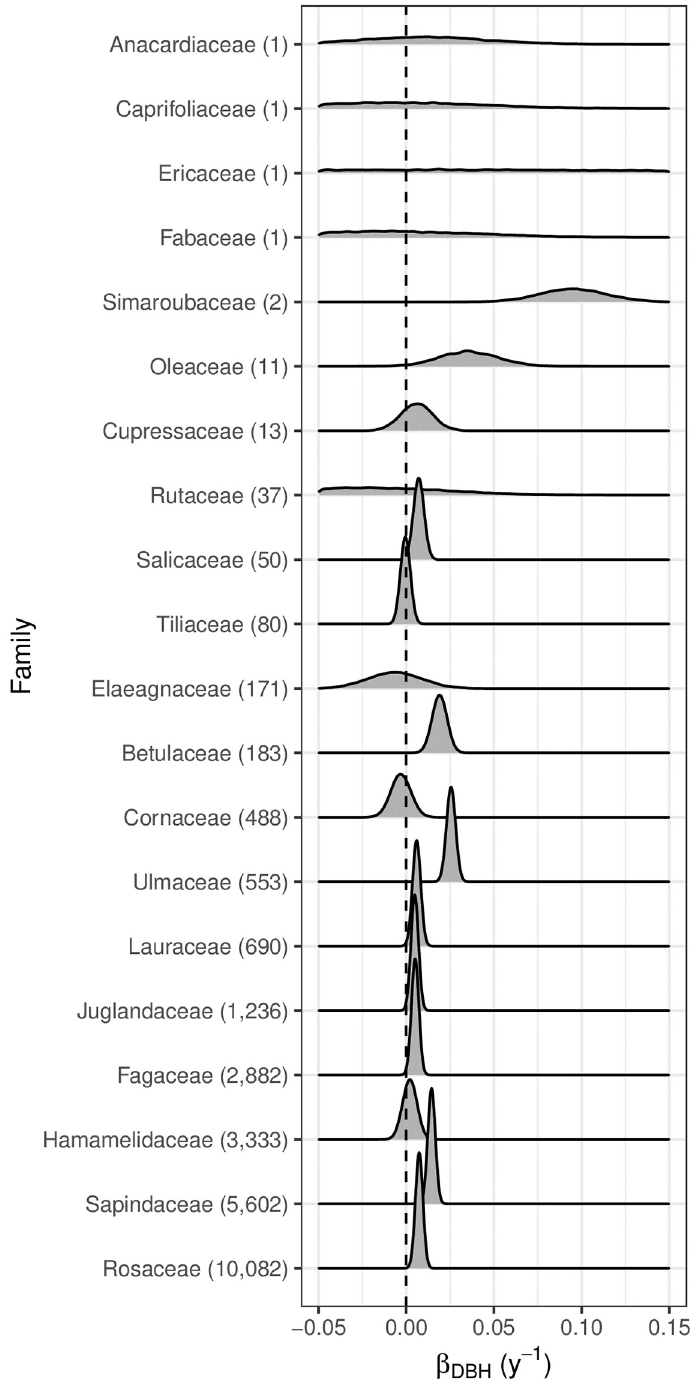
Fig 4. Posterior distribution of β DBH, j for the family-level model. These distributions display the estimated change in annual growth (cm y -1 ) per cm of DBH for each family. Positive values indicate that larger individuals grow faster, while negative values indicate that larger individuals growth